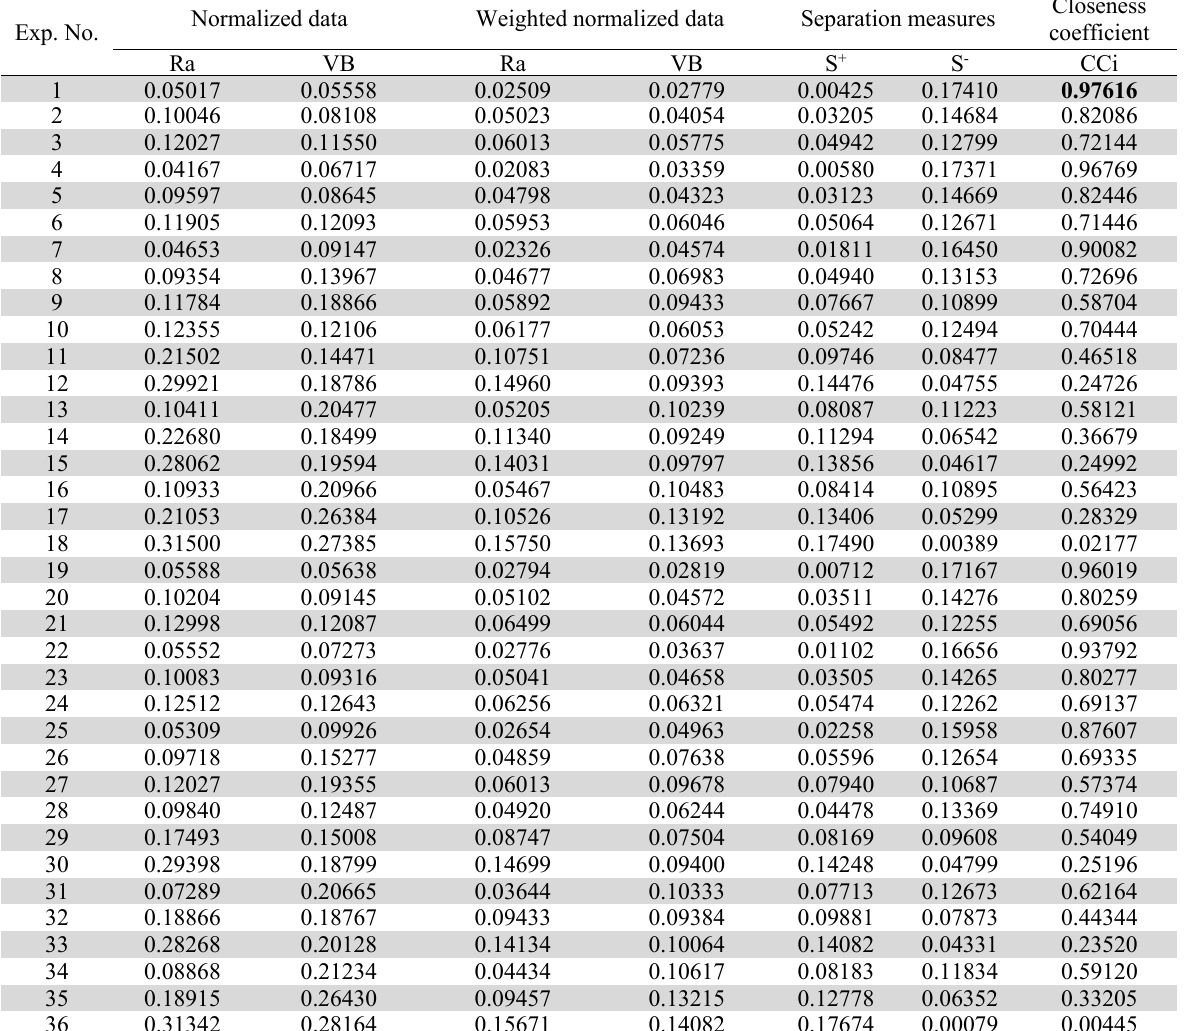
Normalized, weighted normalized data, Separation measures and Closeness coefficient values Exp.